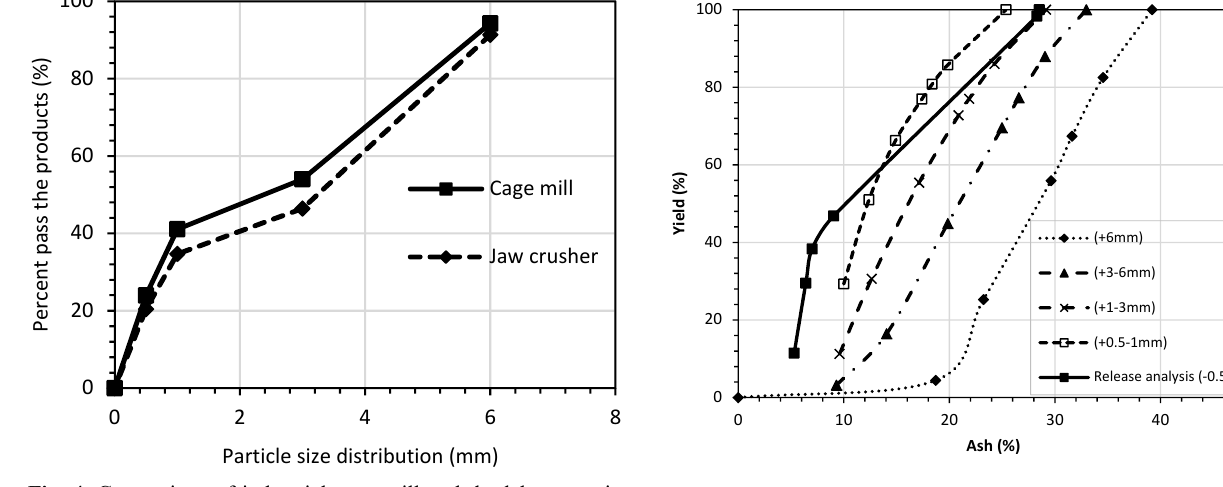
Table 3. The base was +0.5 mm, as it was for feed.